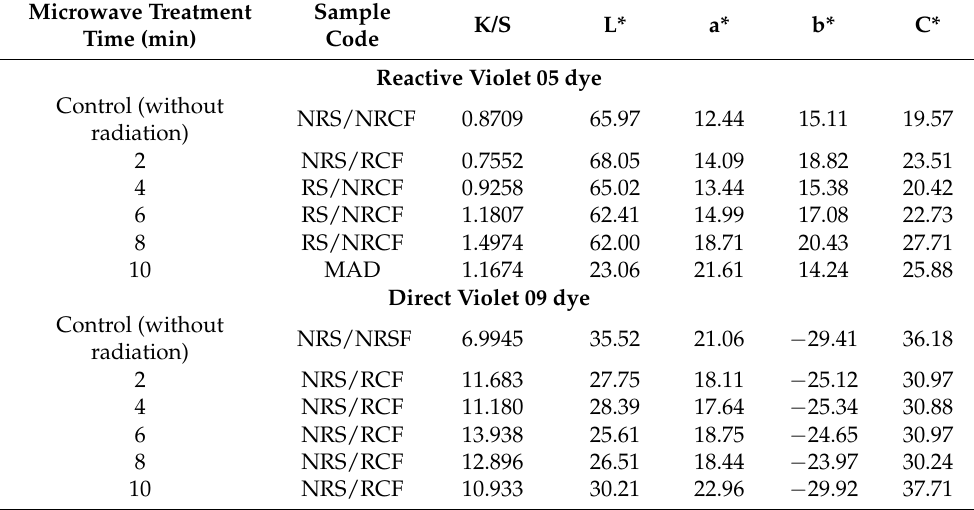
Table 2. Tonal variation cotton fabric dyed with Reactive Violet 05 and Direct Violet 09 dye at selected irradiation